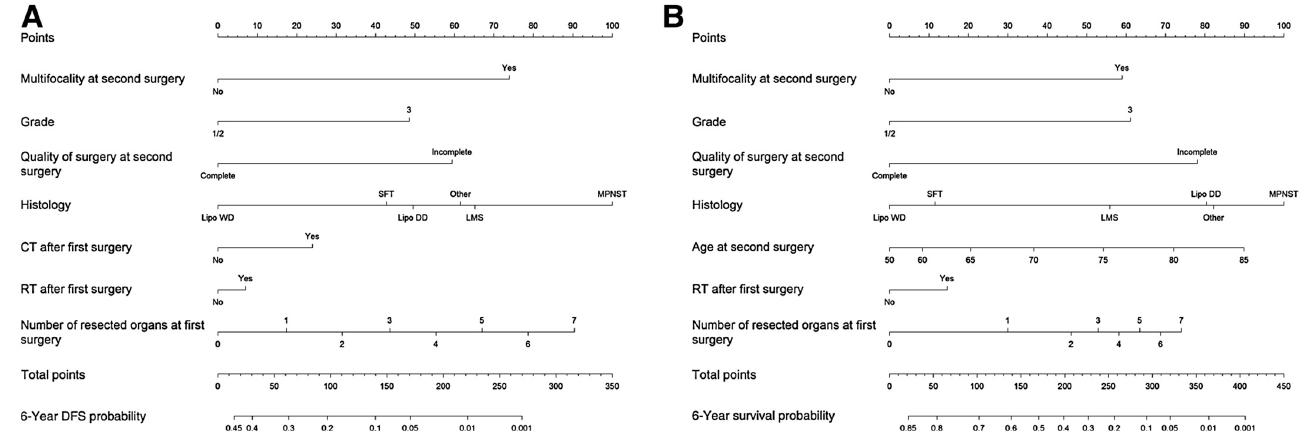
Figure 2. Nomograms to predict 6-year DFS ( A ) and OS ( B ) after second surgery in patients with recurrent RPS. Instructions: each nomogram provides a method of calculating the 6-year DFS or OS probability on the basis of a patient’s combination of covariates. For instance, in the DFS nomogram, locate the patient-speci fi c multifocality at second surgery and draw a line straight up to the “Points” axis to determine the associated score. Repeat for the other nomogram variables, sum the scores, and locate the total score on the “Total Points” axis. Draw a line straight down to the “6-year DFS Probability” axis to obtain the probability. CT, chemotherapy; DFS, disease-free survival; Lipo DD, dedi ff erentiated liposarcoma; Lipo WD, well-di ff erentiated liposarcoma; LMS, leiomyosarcoma; MPNST, malignant peripheral nerve sheath tumor; OS, overall survival; RT, radiotherapy; SFT, solitary fi brous tumor; UPS, undi ff erentiated pleomorphic sarcoma. Reprinted from [49] (no permissions needed for coauthors).